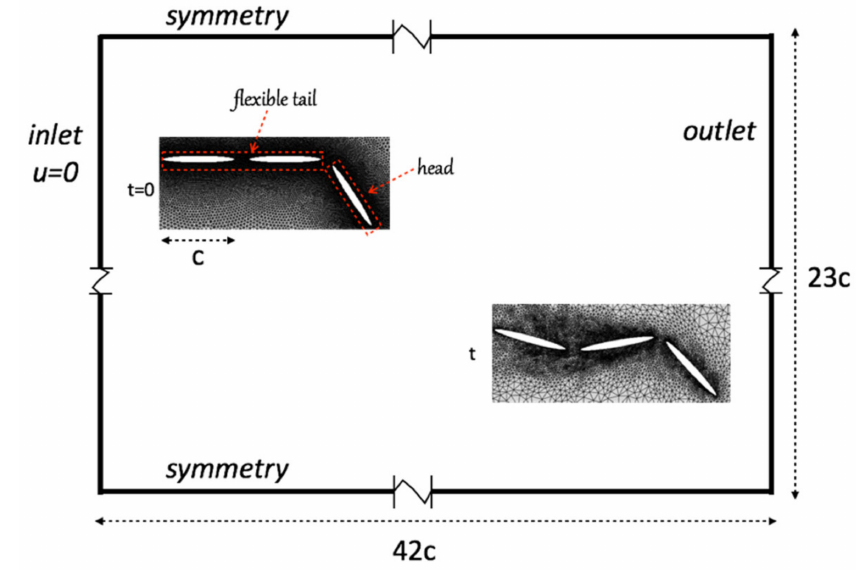
Figure 2. Setup of boundary conditions in fluid